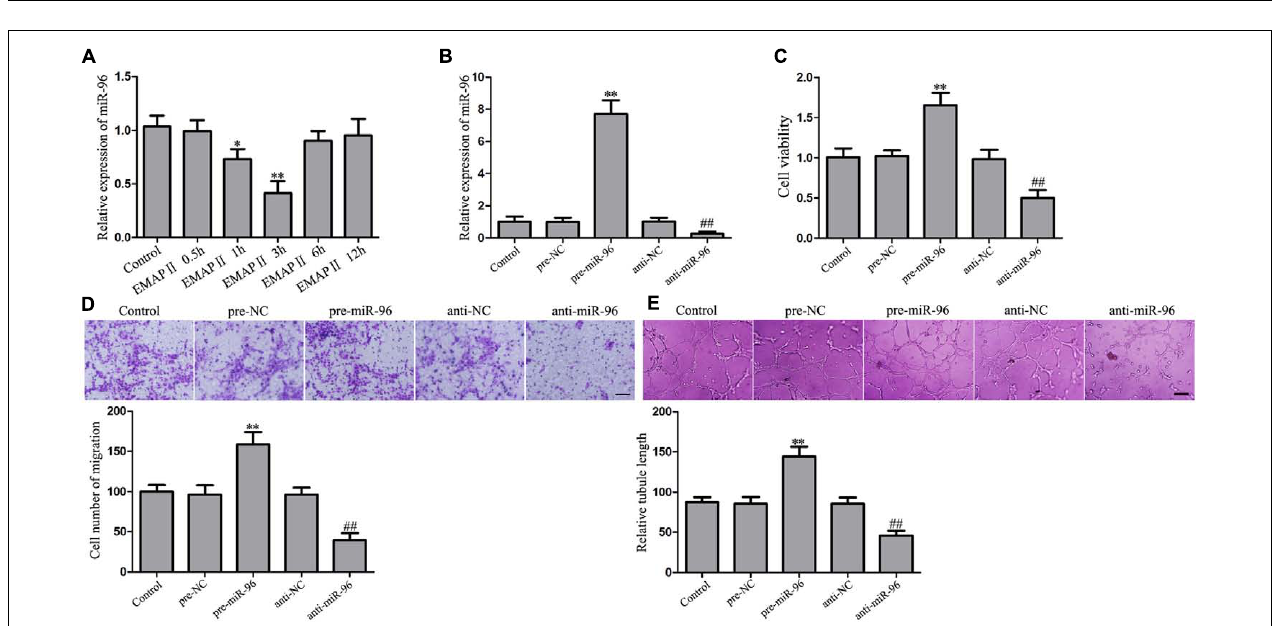
FIGURE 5 | Effect of EMAP II on the expression of UPR-related proteins (GRP78, eIF2 α , and CHOP) in GECs. (A) Western blot analysis was performed to evaluate the expression of UPR-related proteins (GRP78, eIF2 α , and CHOP) after GECs treated with 0.05 nM EMAP II for 0.5, 1, 3, 6, and 12 h. (B) Effect of 0.05 nM EMAP II 3 h and 3-MA on the protein expression of UPR-related proteins (GRP78, eIF2 α and CHOP) in GECs. Data represent means ± SD ( n = 5, each). ∗ P < 0.05 and ∗∗ P < 0.01 vs. control group, ## P < 0.01 vs. EMAP II 3 h group.